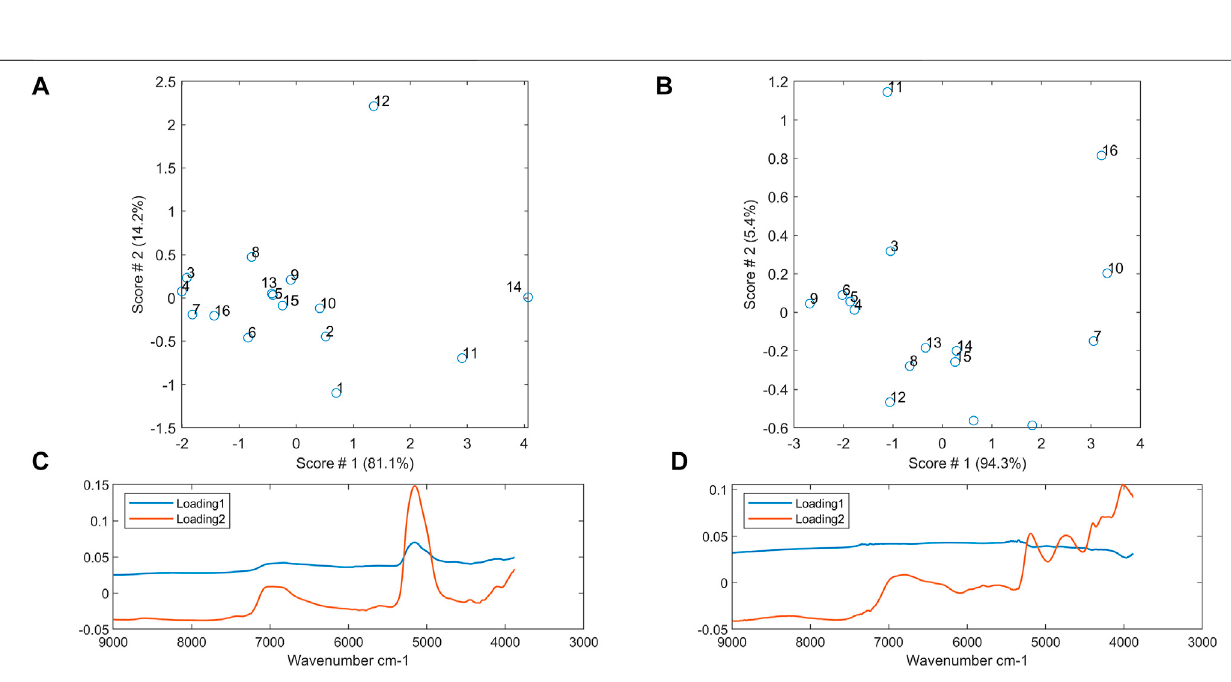
Frontiers in Chemistry |